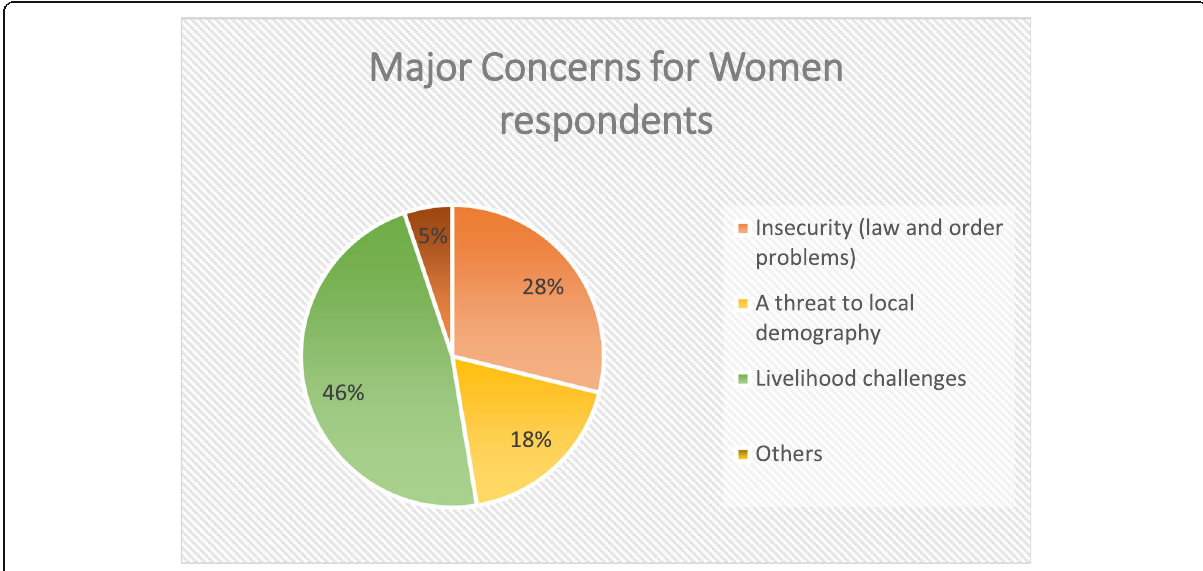
Fig. 1 Key concerns identified by women